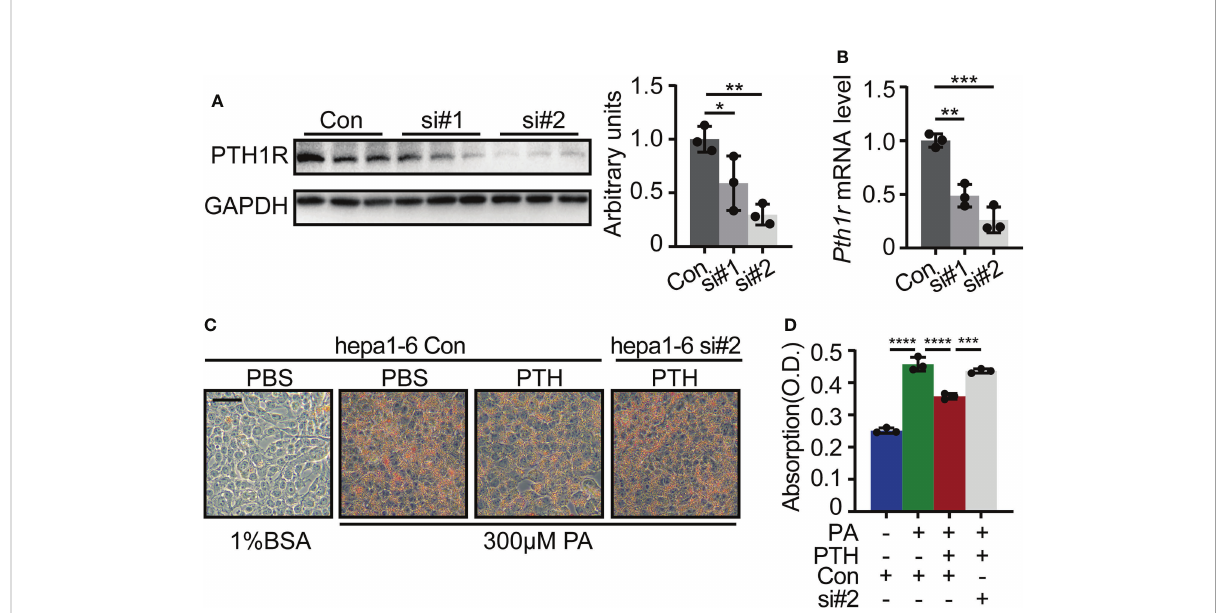
FIGURE 5 Pth1r knockdown abrogated the inhibitory effects of PTH on PA-induced lipid accumulation in Hepa1-6 cells. (A) The PTH1R protein level in Hepa1- 6 cells transfected with Pth1r siRNAs or control. (B) The Pth1r mRNA level in Hepa1-6 cells transfected with Pth1r siRNAs or control. (C, D) Oil Red O staining of Hepa1-6 cells transfected with Pth1r siRNA or control for 30h, and then treated with 0.3 mM PA and 10 nM PTH for 24h (C) , Scale bar = 50 m m). Quantitative assessment of intracellular lipid content was determined by the absorption of 2-propanol elution of the cells (D) . Data are shown as mean ± SD, the cell experiments were repeated three times. *P < 0.05; **P < 0.01; ***P < 0.001; ****P < 0.0001 by one-way